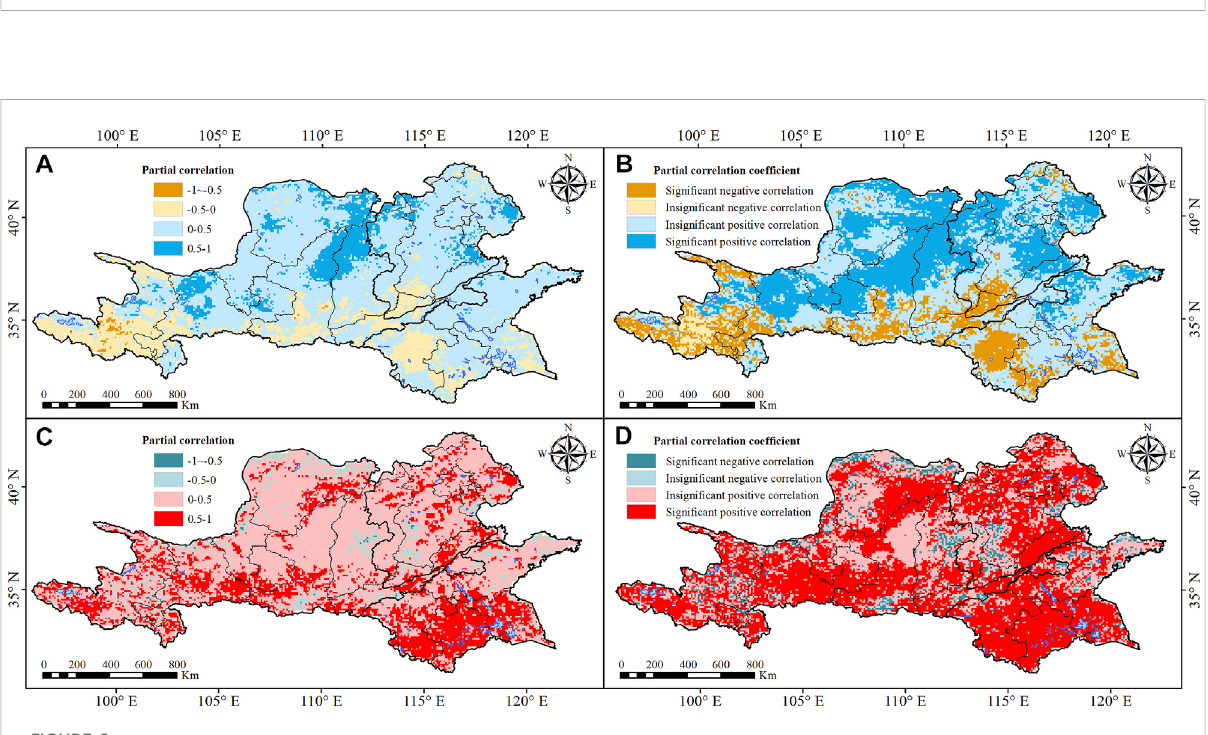
FIGURE 6 Spatialdistributionofthepartialcorrelationcoef fi cientsbetweenNDVIandannualprecipitation (A,B) andannualmeantemperature (C,D) inthe YHHRB from 1982 to